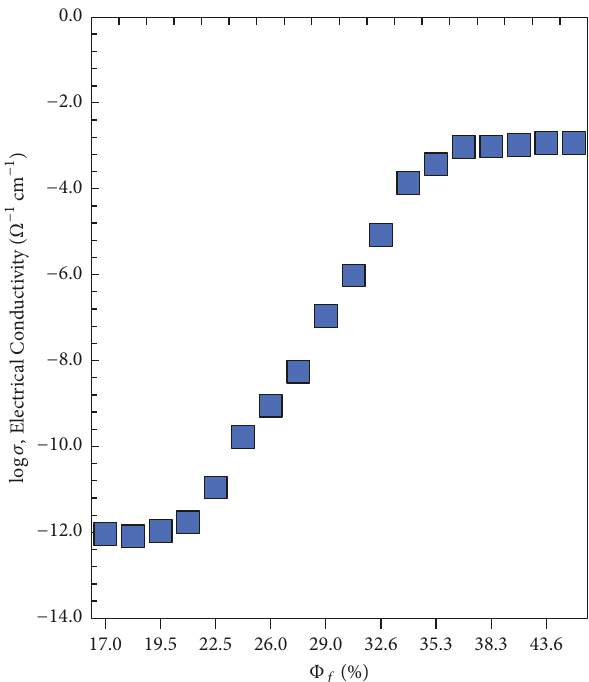
Figure 11: Variation of electrical conductivity of composite speci- mens versus filler rate.